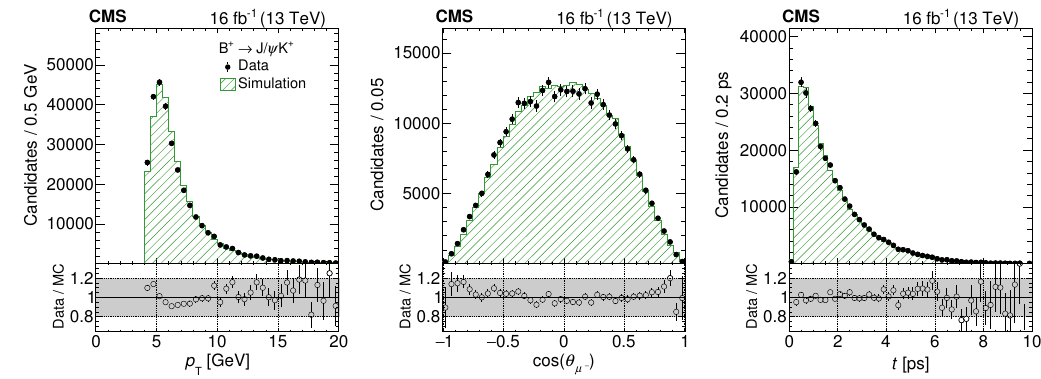
Figure 3 . Comparison of measured and simulated B + ! J = K + distributions for kinematic variables in the central channel for 2016B: the subleading muon p , the muon helicity angle, and T the B meson proper decay time. The events are required to pass the preselection for the analysis BDT training. See text for details. The background-subtracted data are shown by solid circles and the MC simulation by the hatched histogram. The MC histograms are normalized to the number of events in the data. The lower panels display the ratio of the data to the MC simulation. The band in the ratio plot illustrates a (cid:6) 20%